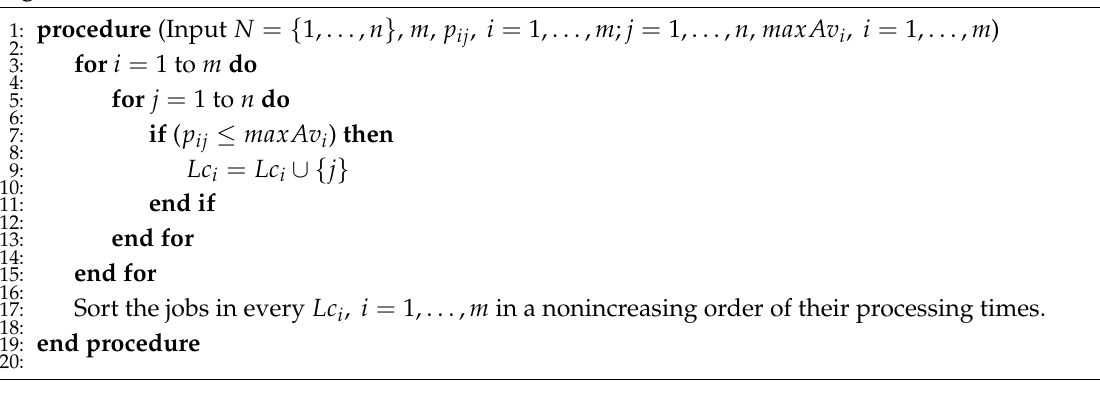
Algorithm 1 Candidate _ Search .